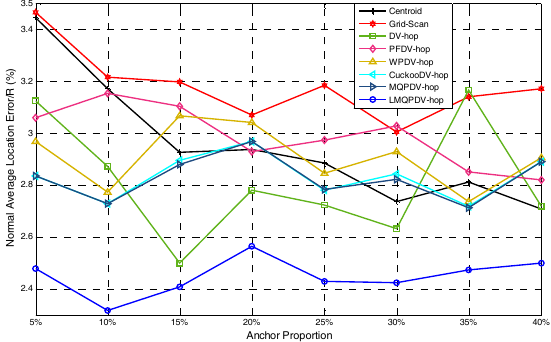
Figure 9. Communication range 150 for WSN#1.